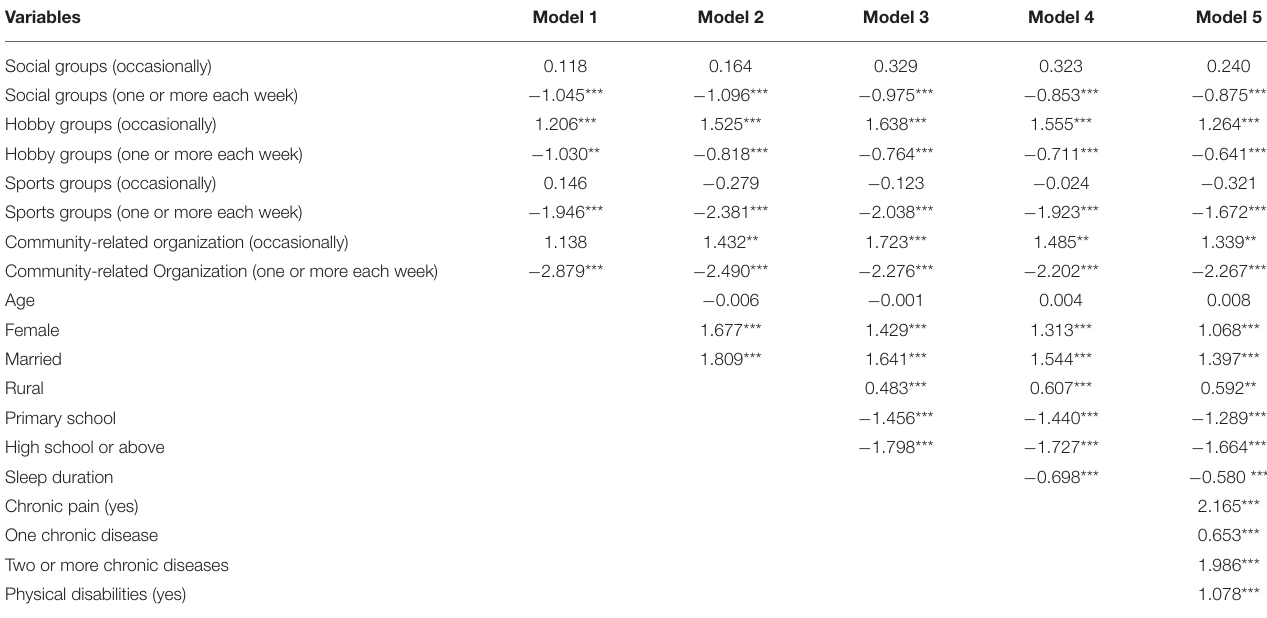
TABLE 2 | Associations between social participation and CESD-10 scores in the older people: multiple regression results ( n =